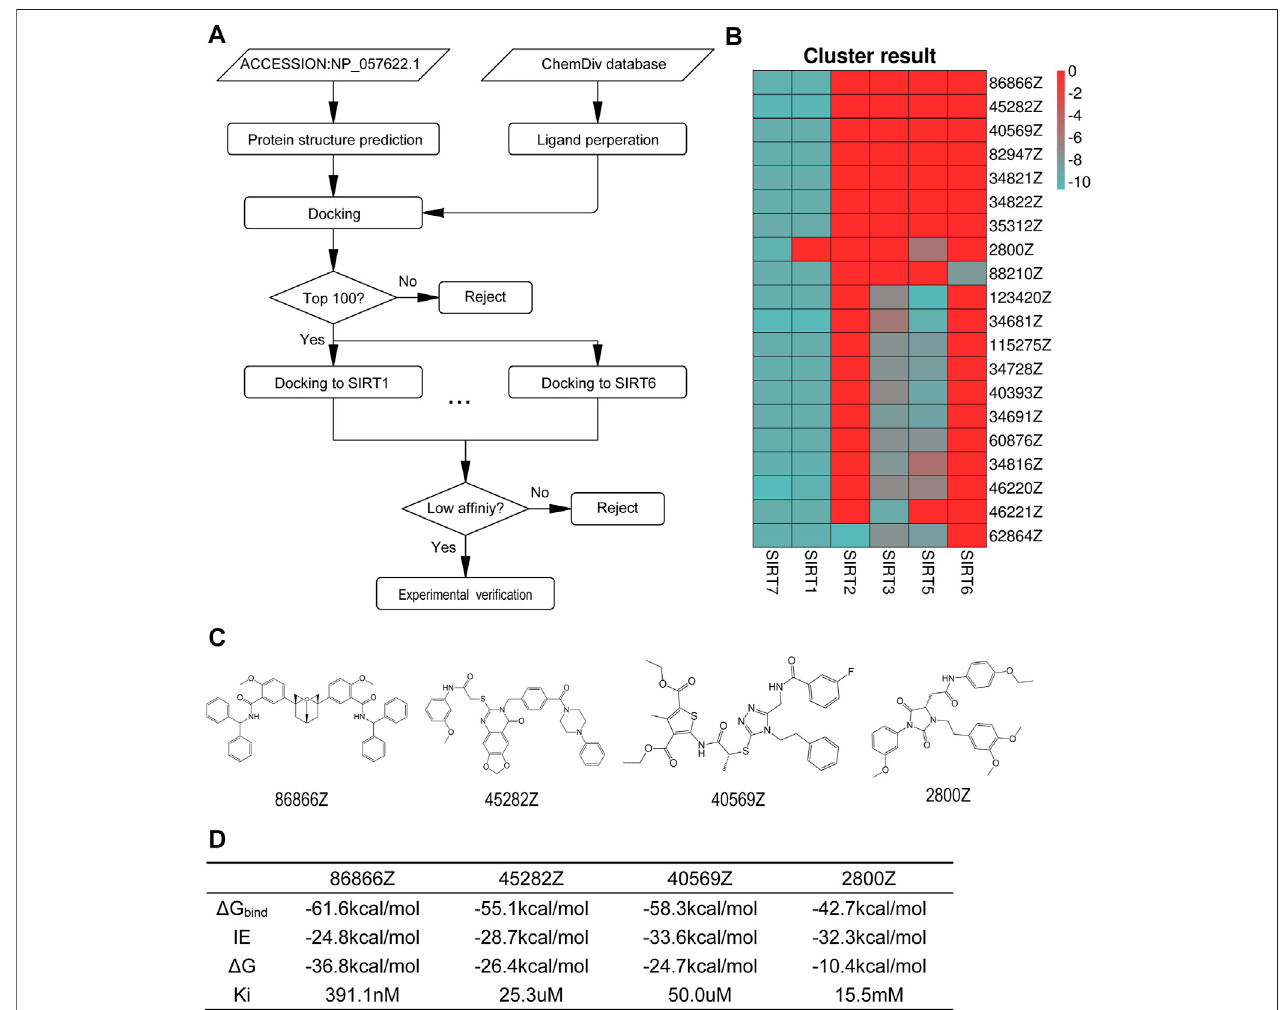
FIGURE2| 2800Zand40569ZwerethepotentialinhibitorstoSIRT7. (A) Thework fl owofvirtualscreeningofspeci fi cSIRT7inhibitor. (B) Thetop20clusterresults by k-means clustering algorithm in R-script. (C) Molecular formula of 86866Z (CID 5295932), 45282Z (CID 46370154), 40569Z (CID 99657111), and 2800Z (CID 97987669)whichwereselectedforexperimentveri fi cation. (D) Thepredictedresultsofbindingfreeenergyfrommoleculardynamicssimulation(kcal/mol). Δ G binding was the binding free energy calculated by MM-PBSA.py using the MM-GBSA method.